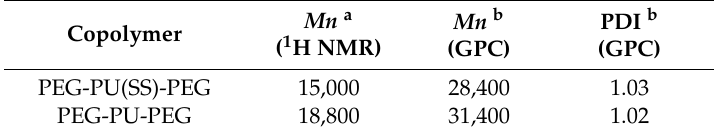
Figure 1. 1 H NMR spectrum (400 MHz, CDCl 3 ) of ( A ) PLA-SS-PLA diol and ( B ) PEG-PU(SS)-PEG. Table 1. Molecular characteristics of PEG-PU(SS)-PEG and